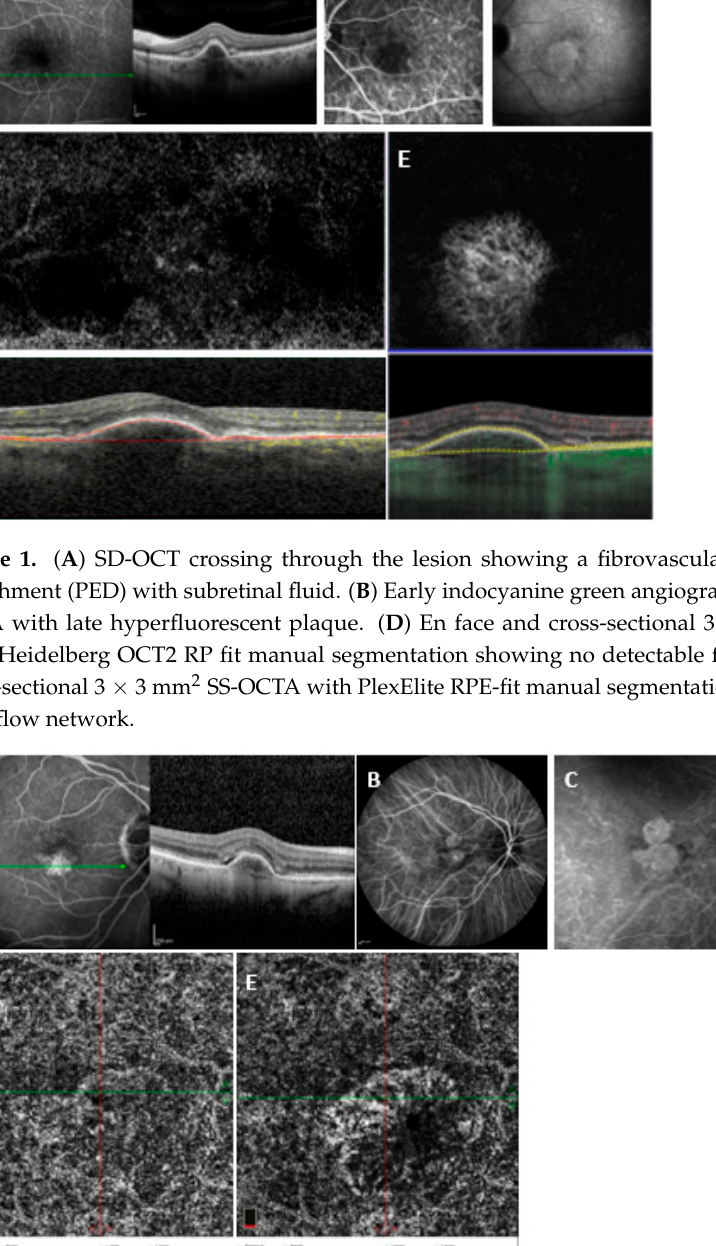
Figure 3. ( A ). SD-OCT. crossing through the lesion showing a flattened irregular PED ( B ). Early fluorescein angiography ( C ). Late indocyanine green angiography with late hyperfluorescent plaque ( D ). ( E ) En face and cross-sectional 6× 6 mm 2 SS OCTA with PlexElite MS Custom segmen- tation showing distinct flow overlay Z. ( F ) Zn face and cross-sectional 3 × 3 mm 2 SD-OCTA with AngioVue automated segmentation showing no detectable flow. 3.3.3. PlexElite OCTA Out of 27 PlexElite examinations, on 1 examination the MNV was undetectable . The sensitivity of detections with automatic segmentation (ORCC, avascular layer and chori- ocapillaris) was 55.5% (15/27) (AUROC = 0.668, specificity = 74.1%, PPV = 68.2%, NPV =